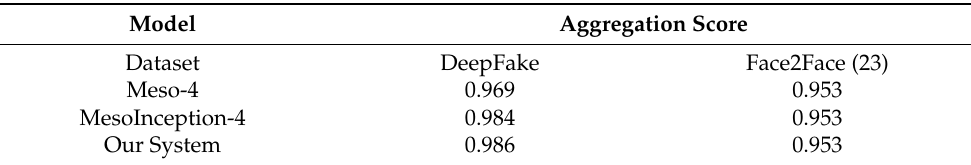
Table 6. Video classification scores using image aggregation, with the DeepFake and Face2Face dataset compressed at rate 23.